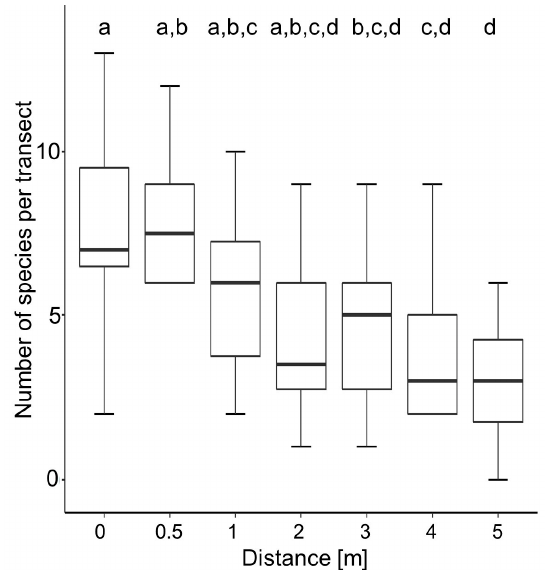
Table 2. ANOVA results of fi xed e ff ects of linear mixed models on di ff erences according to fi eld interior, fi eld edge, and fl ower strip in the number of species and seeds present in the soil seed bank ( fl s: fl ower strip seed mixture species).